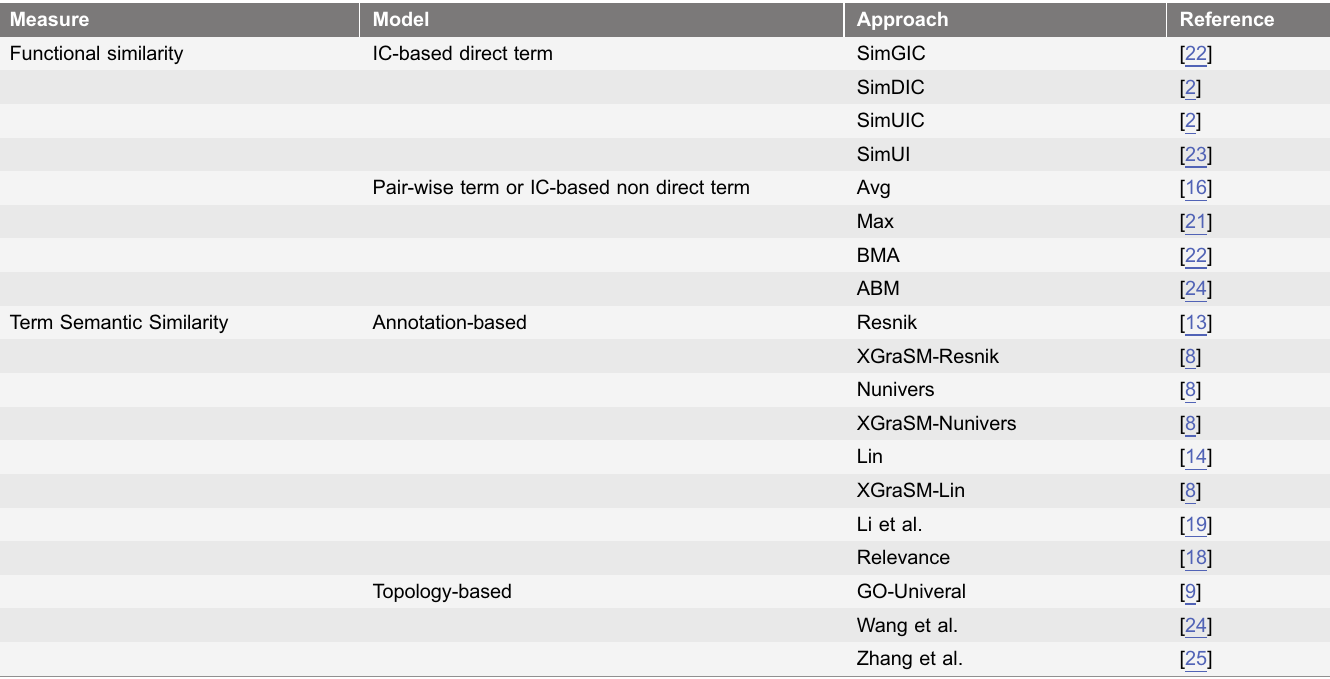
Table 1. Summary of different IC-based functional similarity and term semantic similarity